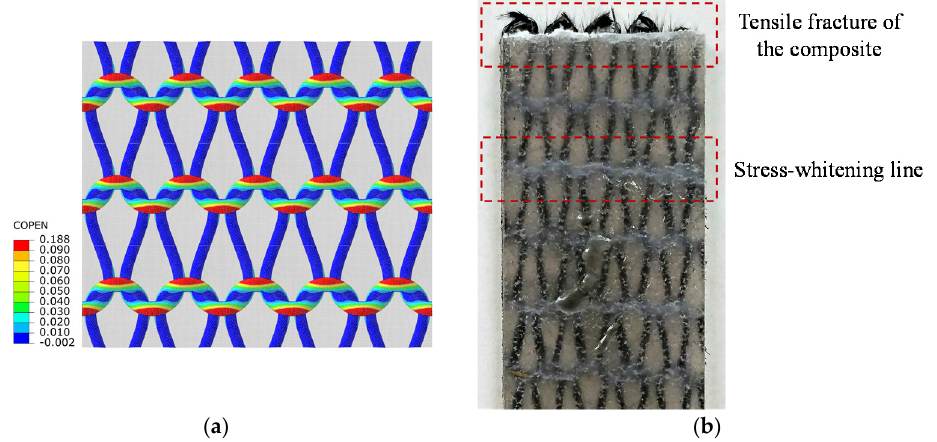
Figure 11. ( a ) The COPEN index shows the separation of fiber tow/matrix interface after loading in the wale direction; ( b ) The fiber tow/matrix separations (stress whitening) which occurred in the test specimen due to the tensile loading in the wale